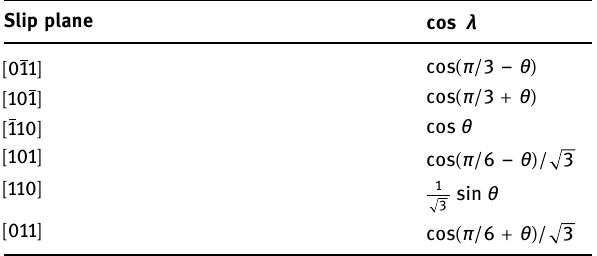
λ cos of the involved slip directions Slip plane